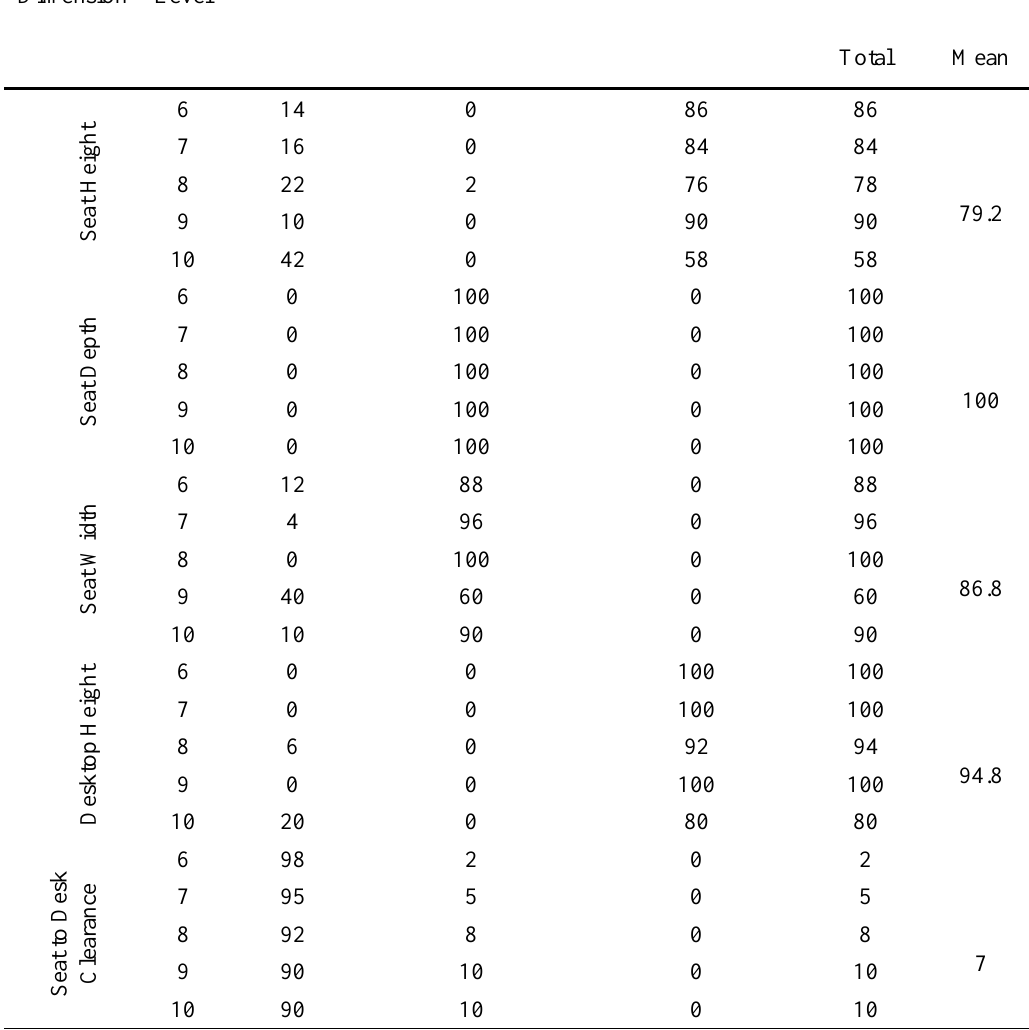
Table 4. Match/Mismatch percentages for existing